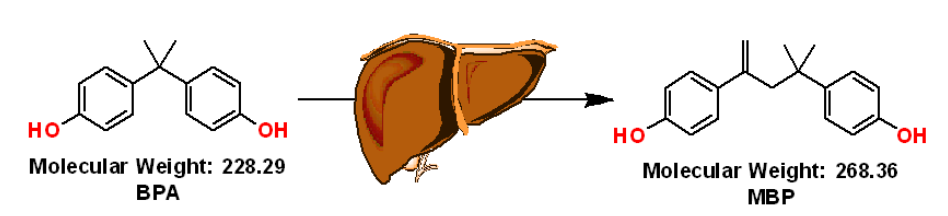
Figure 1. Image depicting metabolism of BPA to MBP in the liver based on the study of Yoshi- hara et al. [7]. A new unique potent BPA metabolite was observed having 40 mass units more than BPA and formed only in the presence of both cytosolic and microsomal fractions. The structure of this potent metabolite was established and named MBP, 4-methyl-2,4-bis (p hydroxyphenyl) pent-1-ene. Although BPA is a weak binder, its active MBP metabolite was several-thousand-fold more estrogenic than BPA. The common BPA replacements like bisphenol F (BPF), bisphenol AF (BPAF),